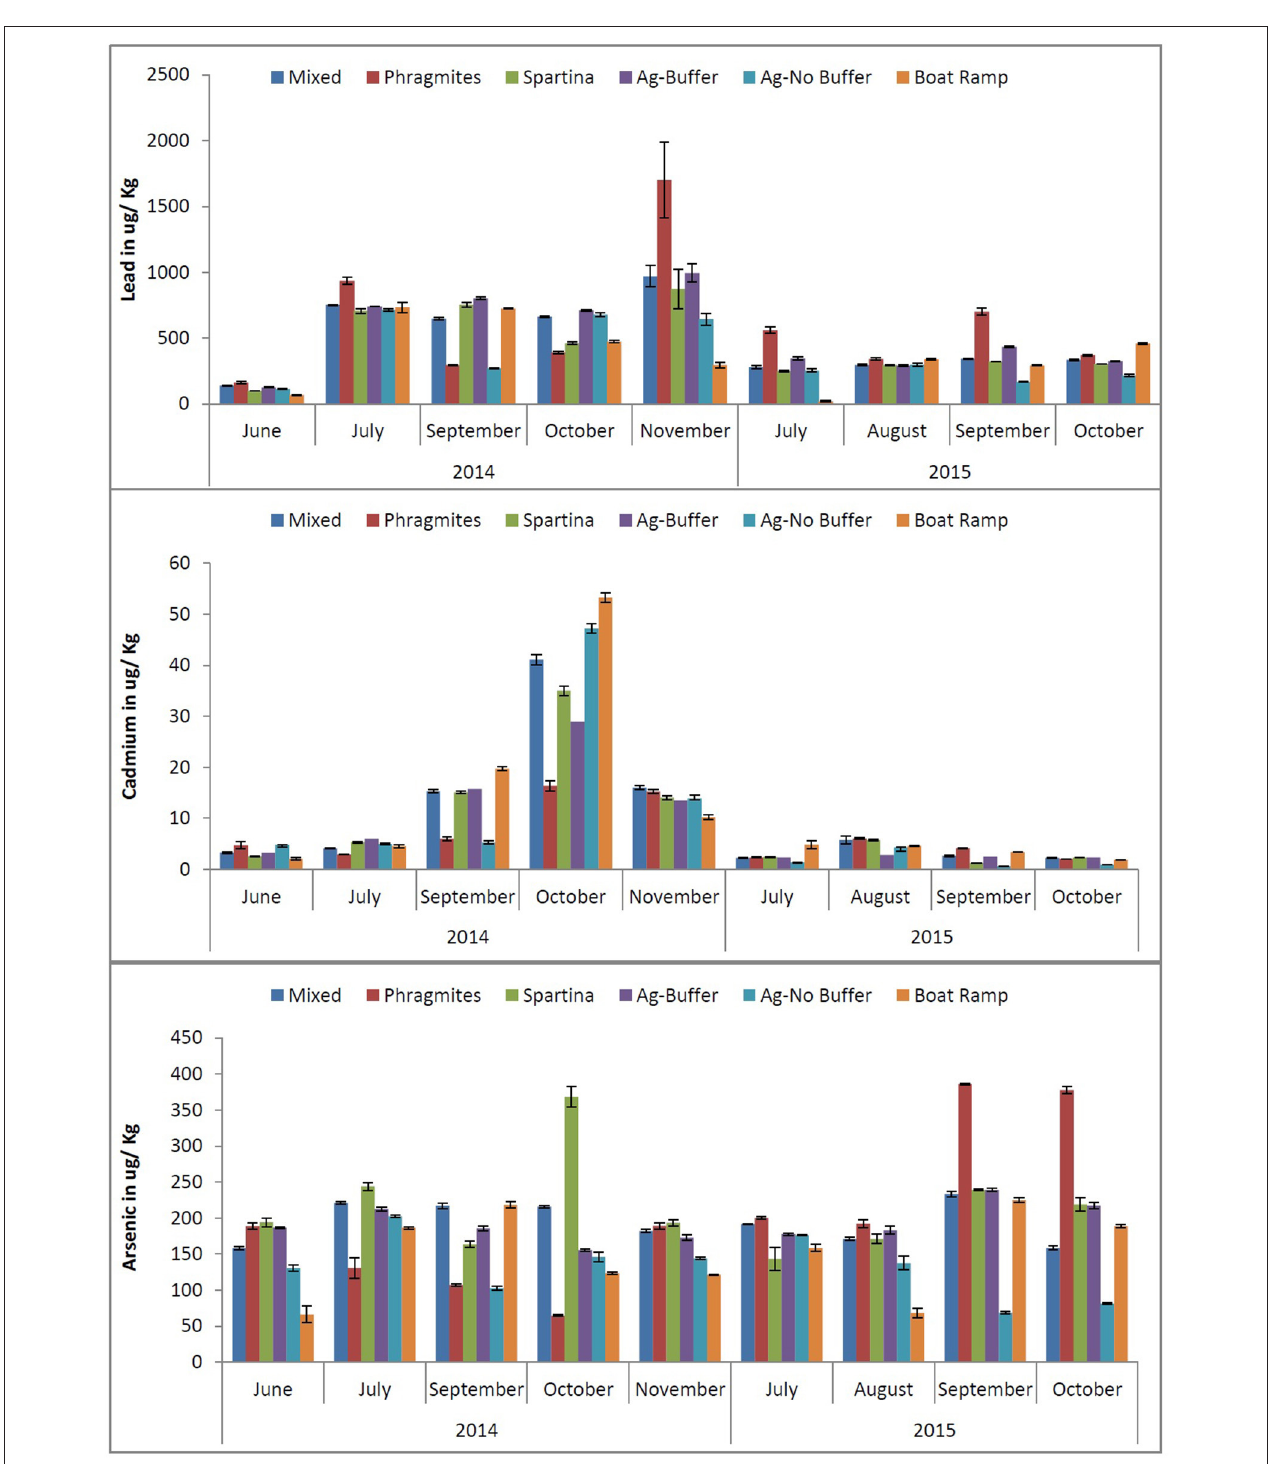
FIGURE 2 | The concentrations of heavy metals (Pb, Cd, and As) in the marsh soils for the six study sites observed during the years 2014 and 2015.